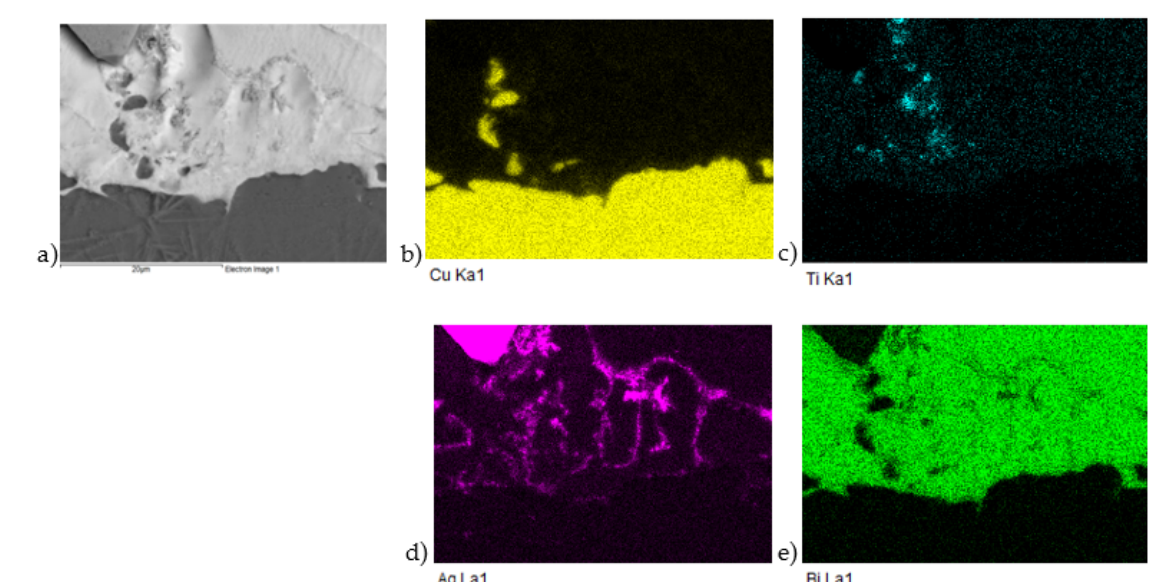
Figure 20. Line EDX analysis of Cu/Bi11Ag1.5Ti joint and the concentration profiles of Cu, Ag, and Bi elements.